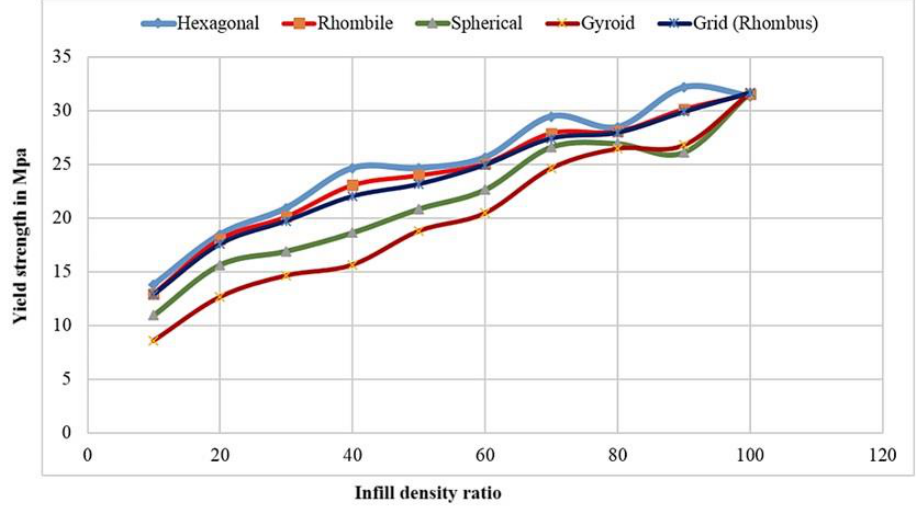
Figure 8. Maximum yield strength obtained in universal testing machine and infill ratio for varied infill structures.